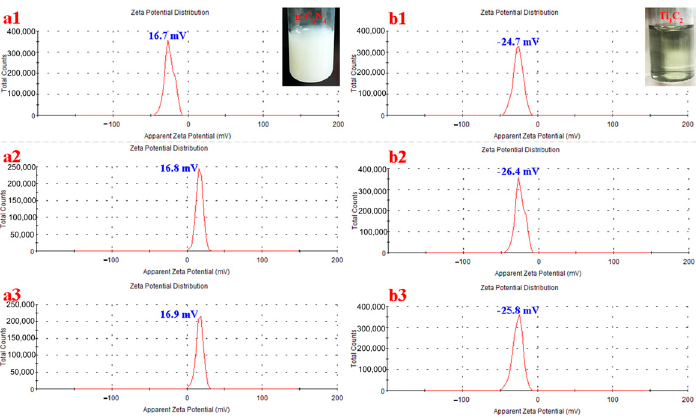
Figure 4. Zeta potential of g-C 3 N 4 ( a1 – a3 ) and Ti 3 C 2 ( b1 – b3 ) aqueous dispersion.